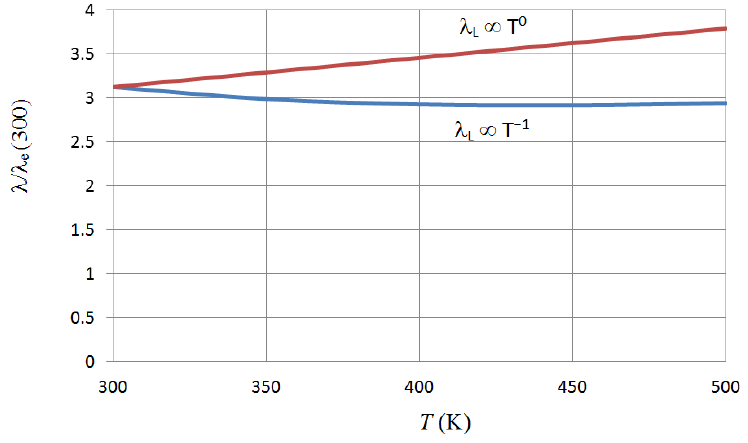
Figure 1. Plot of relative total thermal conductivity against temperature for λ of temperature (upper plot) and for λ